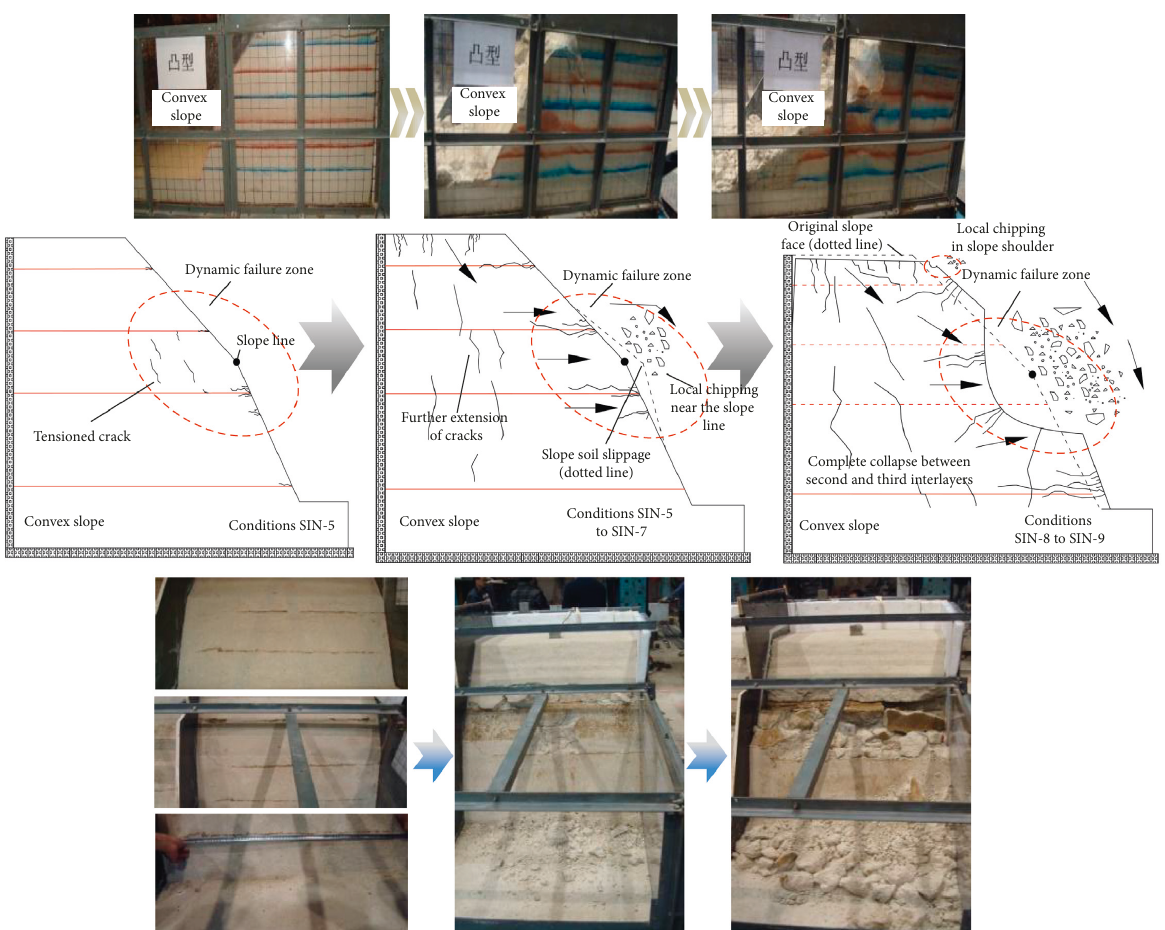
Figure 22: Illustration of the breakage process of convex slope under seismic